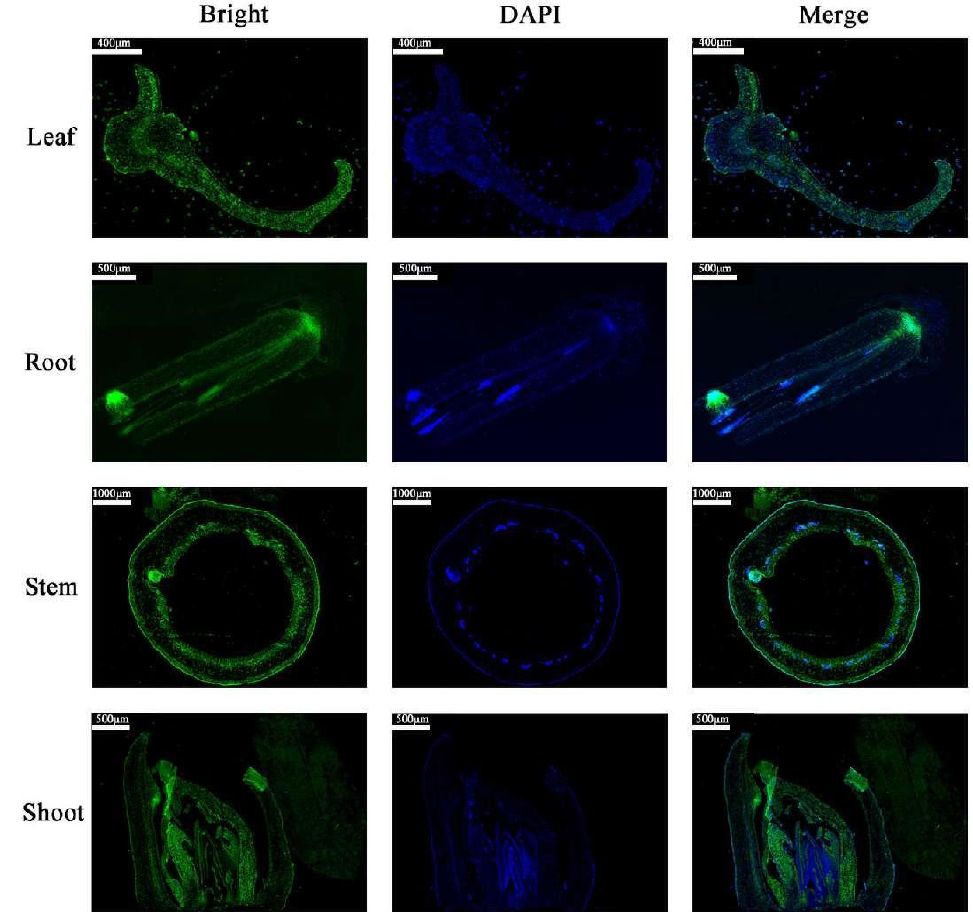
Figure 2 . In situ hybridization of mRNA of MdCoL in leaf, root, stem and bud of columnar apple ‘Wijcik McIntosh’. “Bright” means the fluorescent signals were observed directly, “DAPI” means the fluorescence signal after DAPI (2-(4-Amidinophenyl)-6-indolecarbamidine dihydrochloride) staining. “Merge” represents the superposition image of the above two fluorescence signals.